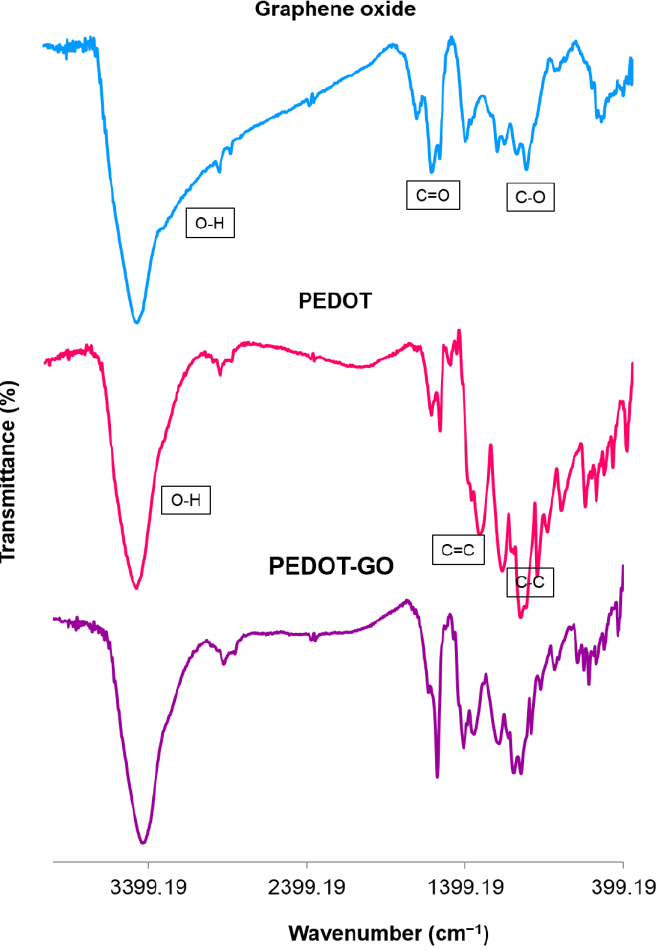
Figure 4. FT – IR spectra of GO, PEDOT, and PEDOT – GO nanocomposite. Figure 4. FT–IR spectra of GO, PEDOT, and PEDOT–GO